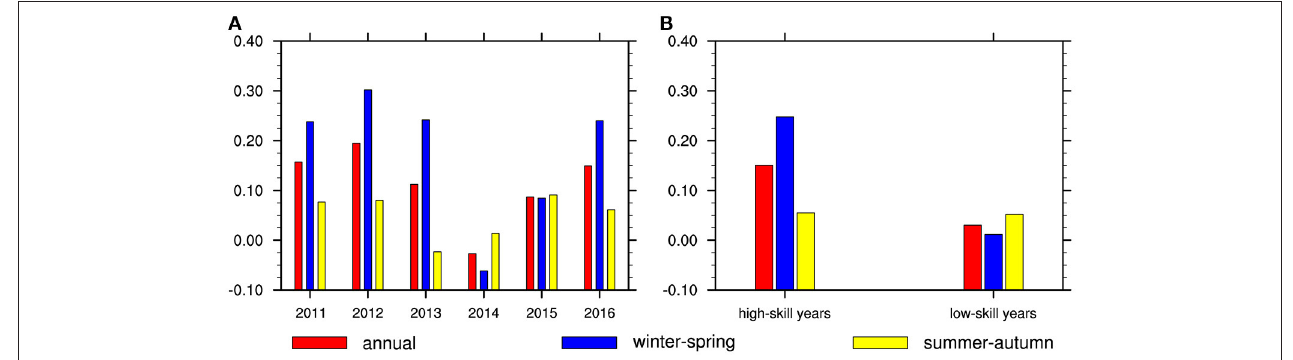
FIGURE 2 | The prediction skill of (A) annual average (red bar), winter–spring season (blue bar), and summer–autumn (yellow bar) for each year of 2011–2016 and of (B) annual average (red bar), winter–spring season (blue bar), and summer–autumn (yellow bar) for high-skill years and low-skill years,